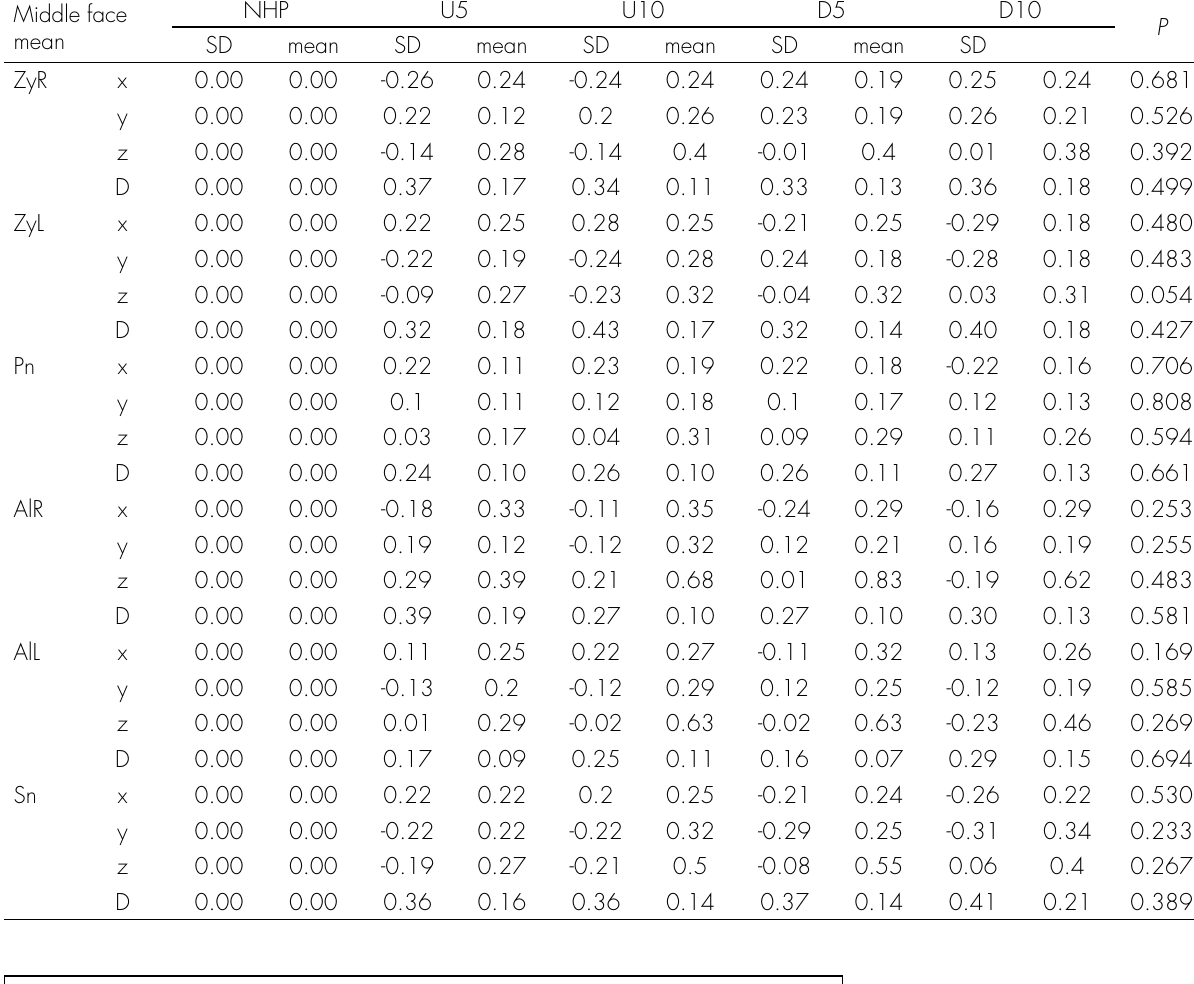
Table III. Changes in the middle facial soft tissue landmarks according to head posture